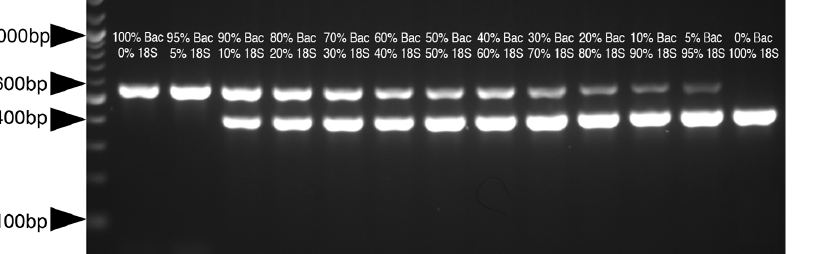
Figure 3. Assay Template Composition versus Relative Band Brightnesses for a Simulated Culture Series. The simulated culture assay series demonstrates that the relationship between assay template composition and relative band brightness still holds even in the presence of background non-target DNA. The agarose gel shows the amplification of PCR products from a simulated culture assay series. The percentages given correspond to the percentage of the 2 m l template DNA that was bacterial Marinomonas sp. gDNA or D. grandis 18S target sequencing-containing linearized plasmid. Both the bacterial gDNA and linearized plasmid were diluted such that the estimated concentration of 16S or 18S target sequence was equal at 0.1 ng/ m l. The 100 bp ladder (Invitrogen) is shown in the first lane with the 1000 bp, 600 bp, 400 bp and 100 bp markers noted.